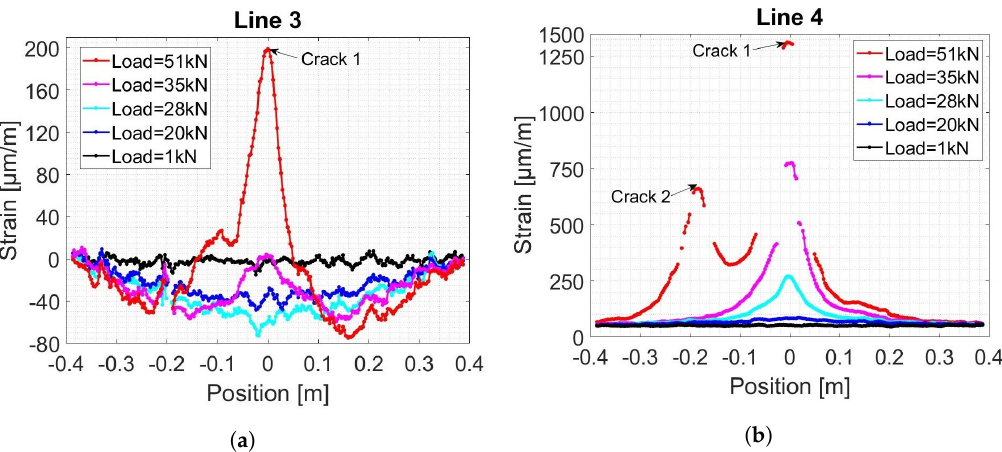
Figure 8. Spatial strain distribution in concrete measured by the DFOS system near the top ( a ) and bottom ( b )